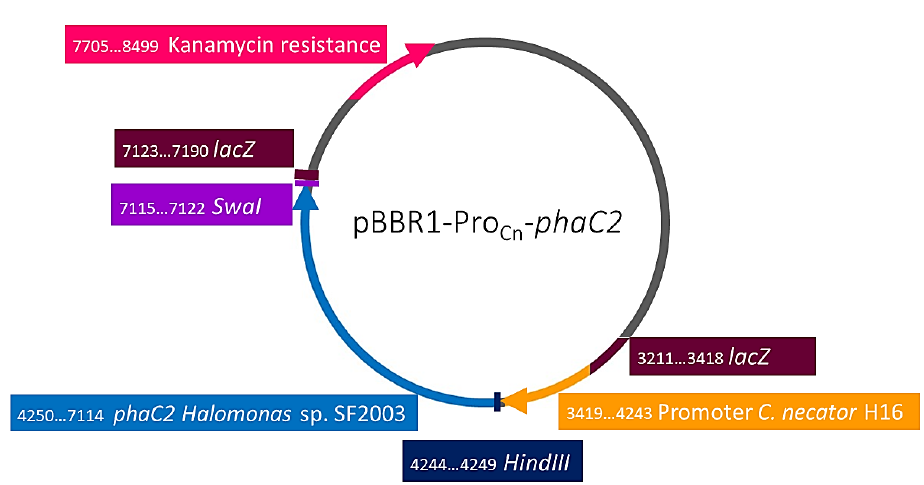
Figure 1. pBBR1-Pro Cn - phaC1 plasmid map.